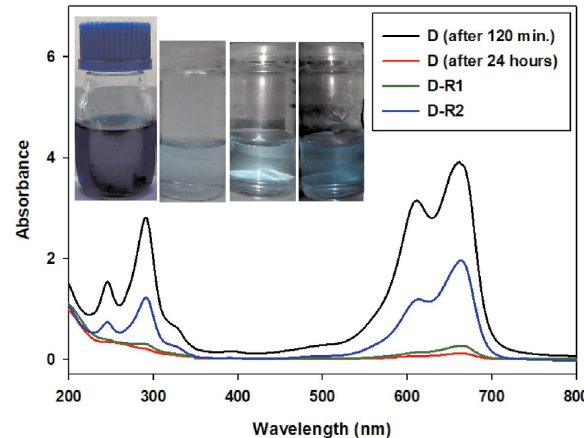
Fig. 7. XRD patterns of the ceramic membrane before and after MB adsorption.